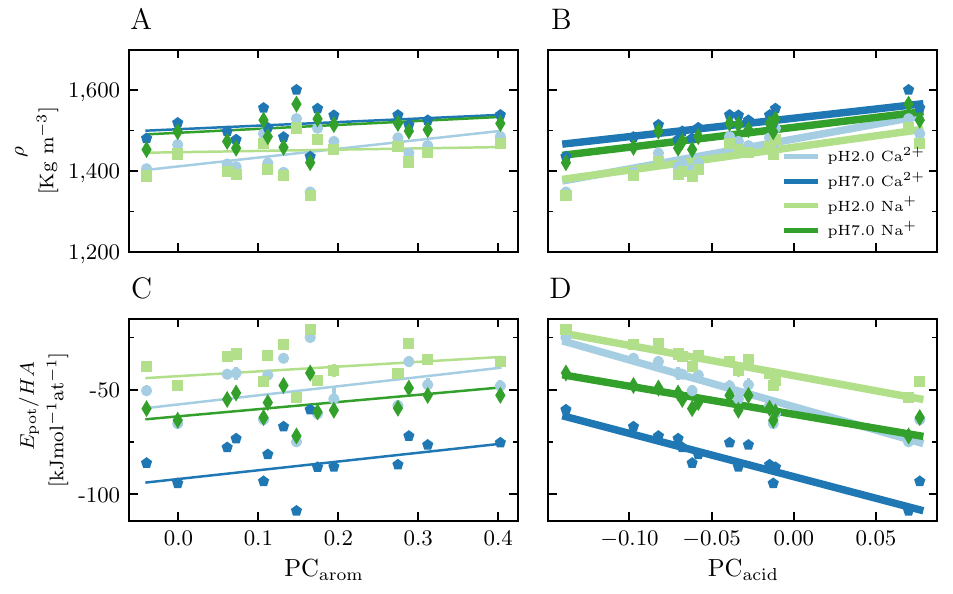
Figure 2. Properties of the standard humic substances as a function of the first two principal components. Each point represents the average over four independent simulations with error bars representing the standard error. Each plot has a fitted line using linear regression, which is presented with a tick curve if the R 2 is greater than 0.6. ( A , B ) Density and ( C , D ) Total potential energy of the system normalized by the number of heavy atoms as a function of the PC arom and PC acid of the humic